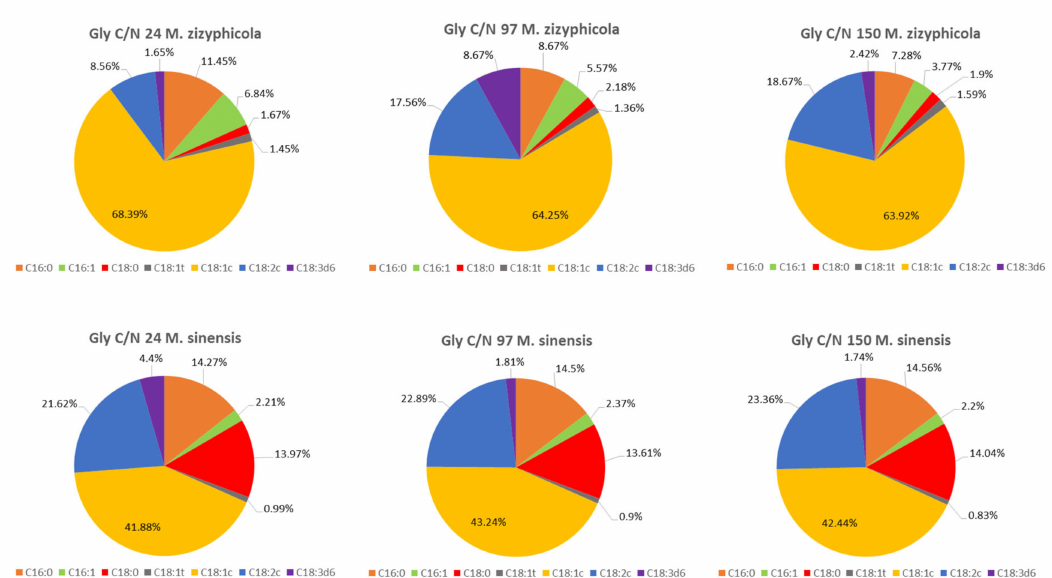
Figure 5. Fatty acid profile of M. zizyphicola 1247 and M. sinensis 1244 on glycerol media with different C/N ratios (24, 97 and 150). C16:0-palmitic acid; C16: 1-palmitoleic acid; C18:0 - stearic acid; C18: 1t-elaidic acid; C18: 1c-oleic acid; C18: 2c-linoleic acid; C18: 3d3- α -linolenic